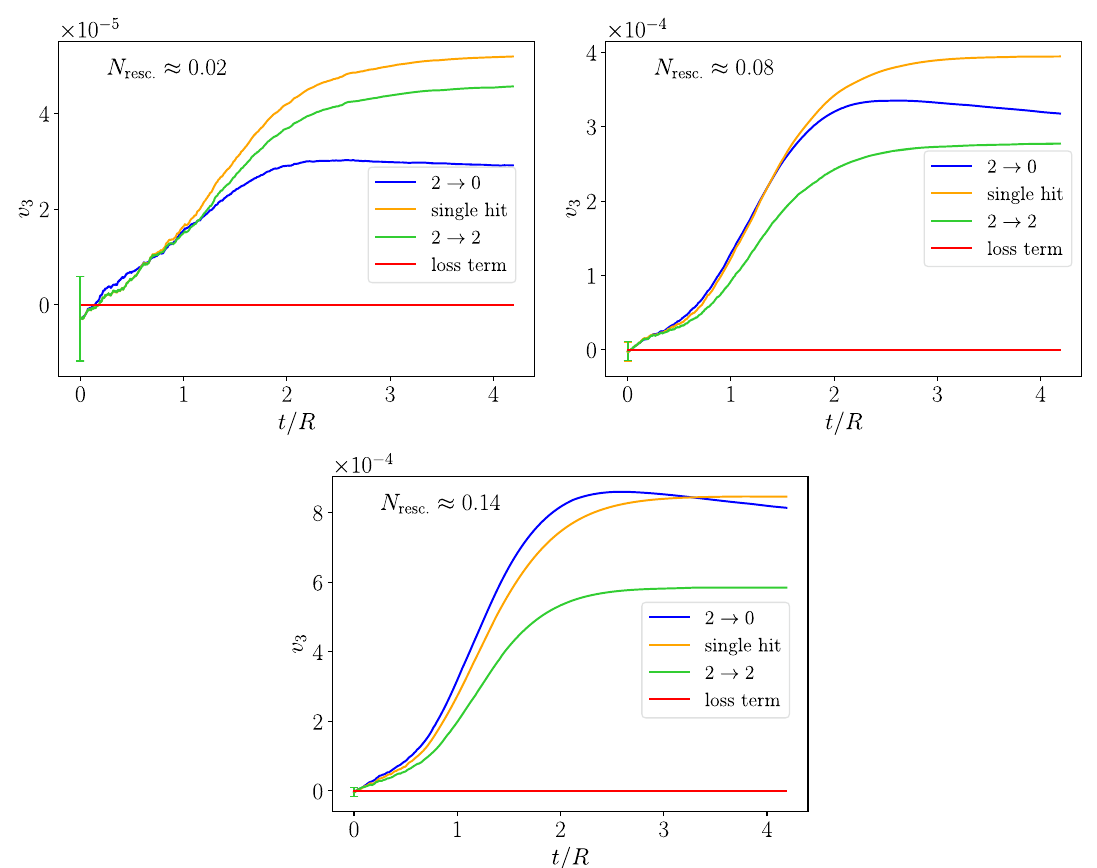
Fig. 5 Time dependence of triangular flow v 3 in systems with initially systems with elastic binary scatterings, the blue lines for the 2 → 0 ε = 0 . 15 and on average N ≈ 0 . 02 (top left), 0.08 (top right) collision kernel, and the orange curves for the single-hit model. The 3 resc . constant red line v 3 = 0 is the output of the analytical approach or 0 . 14 (bottom) rescatterings per particle. The green curves are for